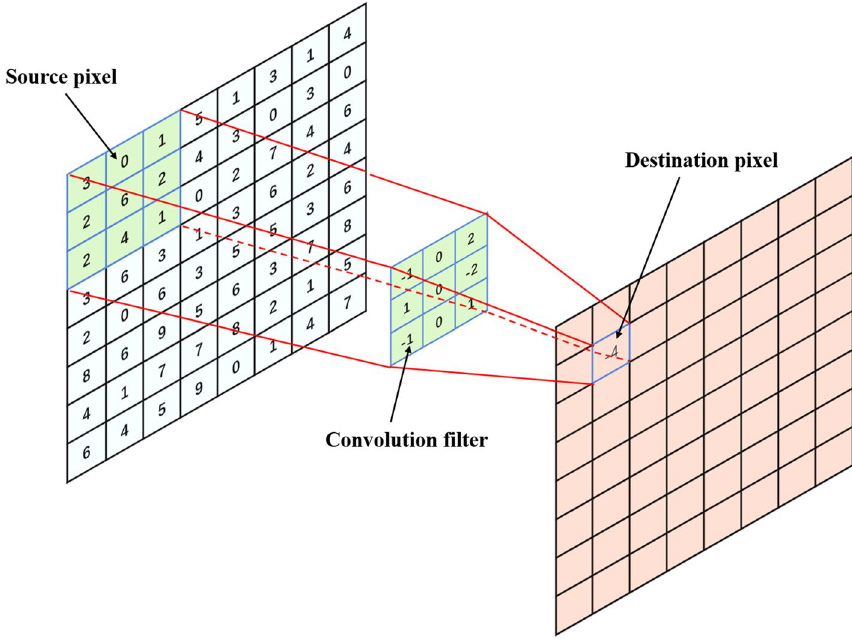
Figure 5. Example of information limitations of convolution